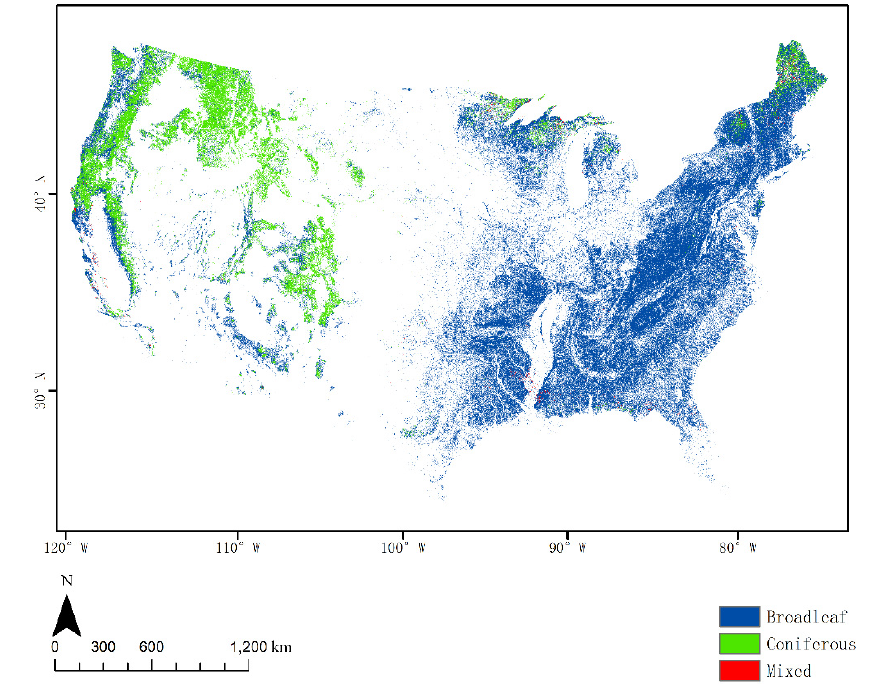
Figure 11. Integration Model II: second-level class refinement results of Globeland30 forest.